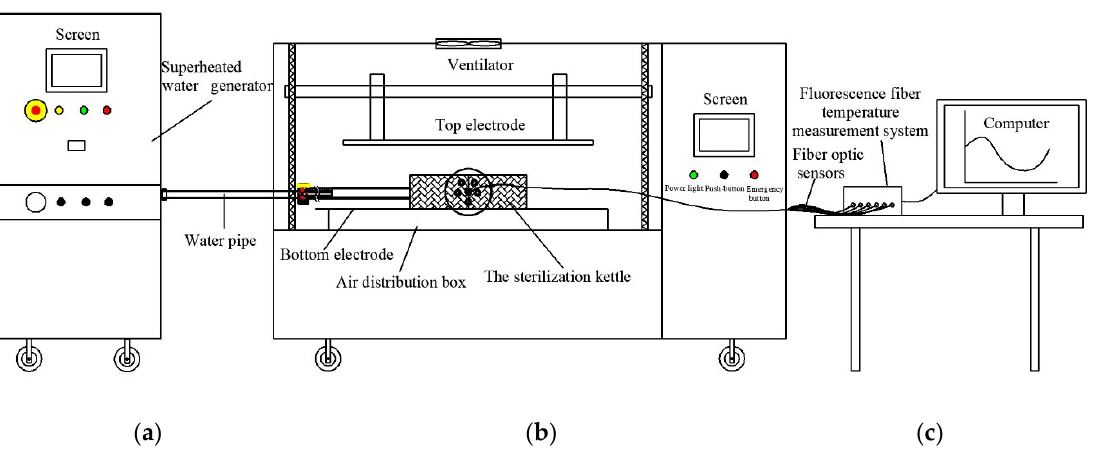
Figure 2. Simplified schematic diagram of RFSW heating system including superheated water generator ( a ), radio frequency heating system ( b ), and fiber optic temperature measurement system ( c ).